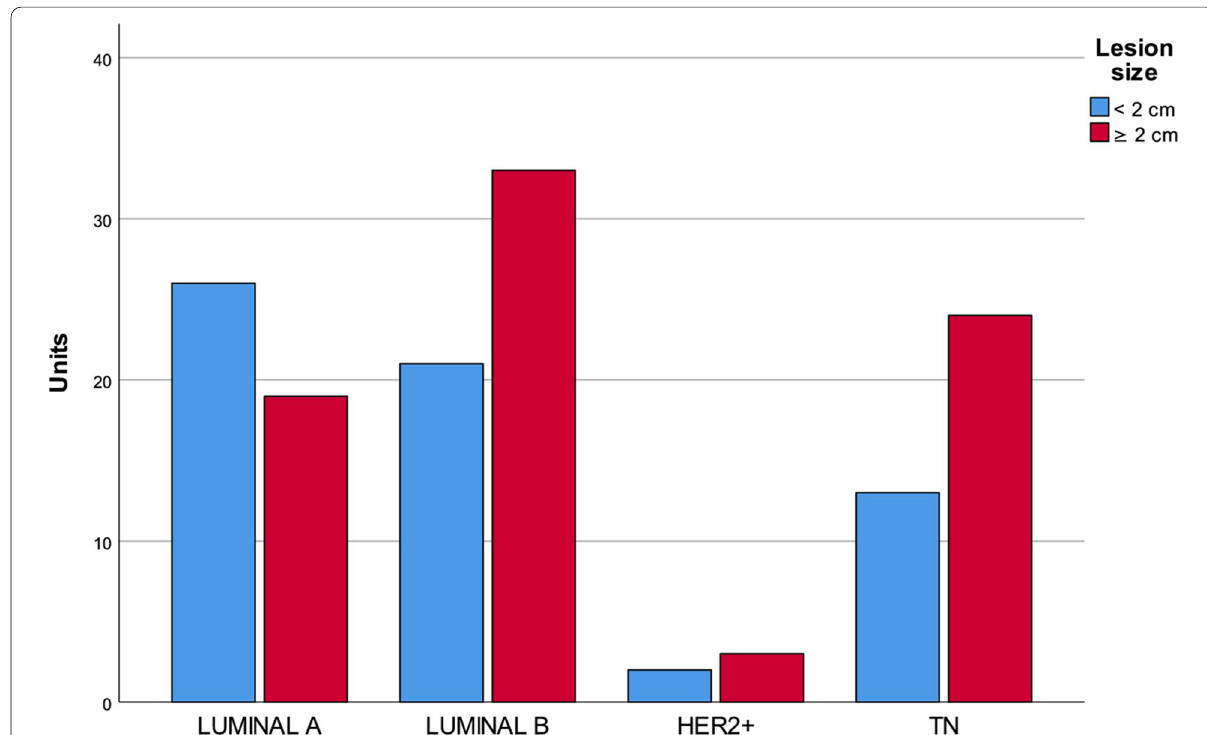
Fig. 2 Distribution of the molecular subtypes of breast cancer (luminal A-like, luminal B-like, HER2 positive, and triple negative) according to lesions